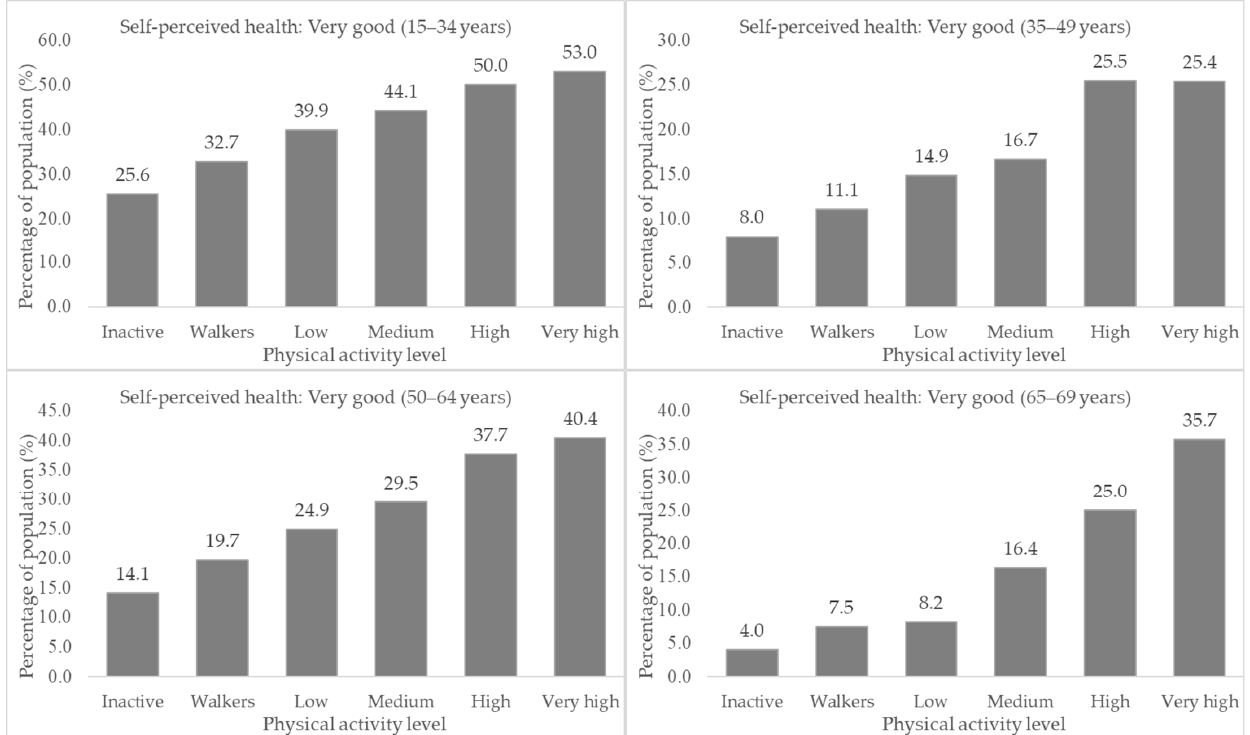
Figure 2. Associations between the level of physical activity and self-perceived health by age groups in the Spanish population through the ENSE 2017.